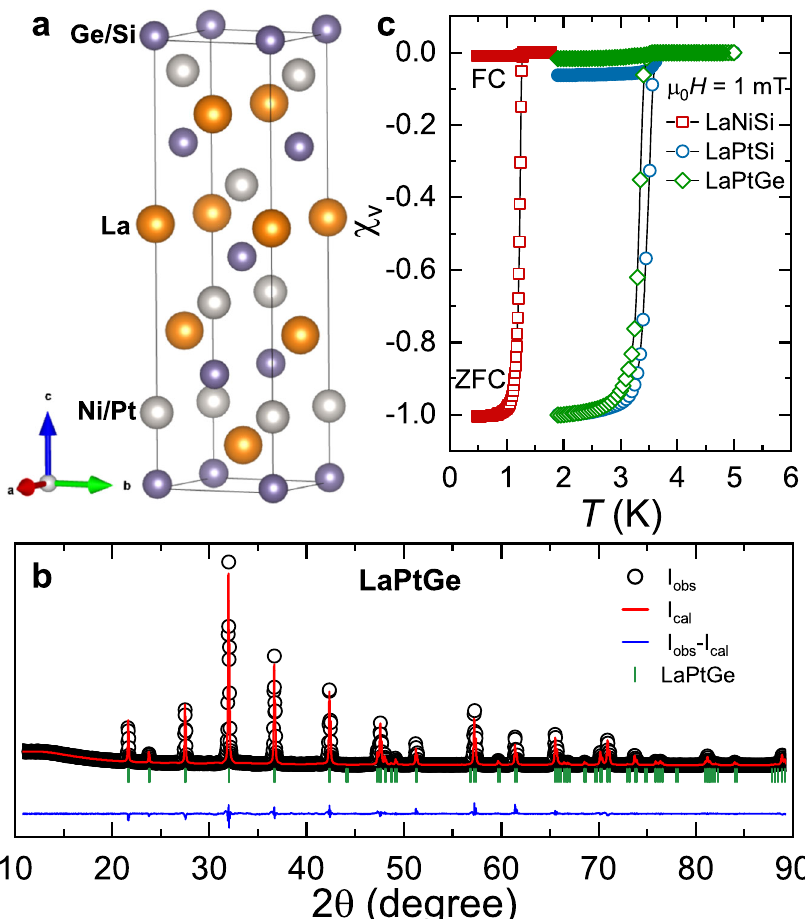
Fig. 1 Crystal structure and bulk superconductivity. a Crystal structure of LaNiSi, LaPtSi, and LaPtGe. b Room-temperature XRD pattern and Rietveld re fi nements for LaPtGe. The black circles and the solid-red line represent the experimental pattern and the Rietveld re fi nement pro fi le, respectively. The blue line at the bottom shows the residuals, i.e., the difference between calculated and experimental data. The vertical bars mark the calculated Bragg-peak positions for LaPtGe. The Rietveld re fi nements of LaNiSi and LaPtSi are shown in the Supplementary Fig. 1. c Temperature dependence of the magnetic susceptibility. The zero fi eld-cooled (ZFC) and fi eld-cooled (FC) magnetic susceptibility were measured in a fi eld of μ 0 H = 1 mT. The well distinct ZFC- and FC curves are consistent with type-II SC, as con fi rmed also by μ SR